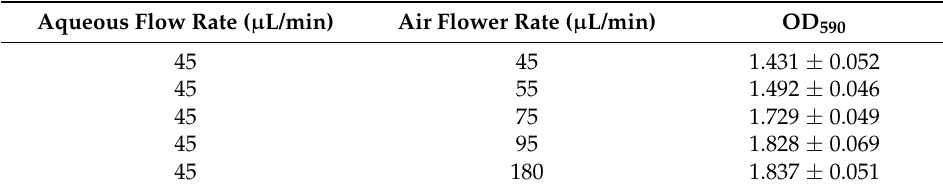
Table 1. Effect of oxygen content on E. coli biofilm formation in the microchannel reactor.